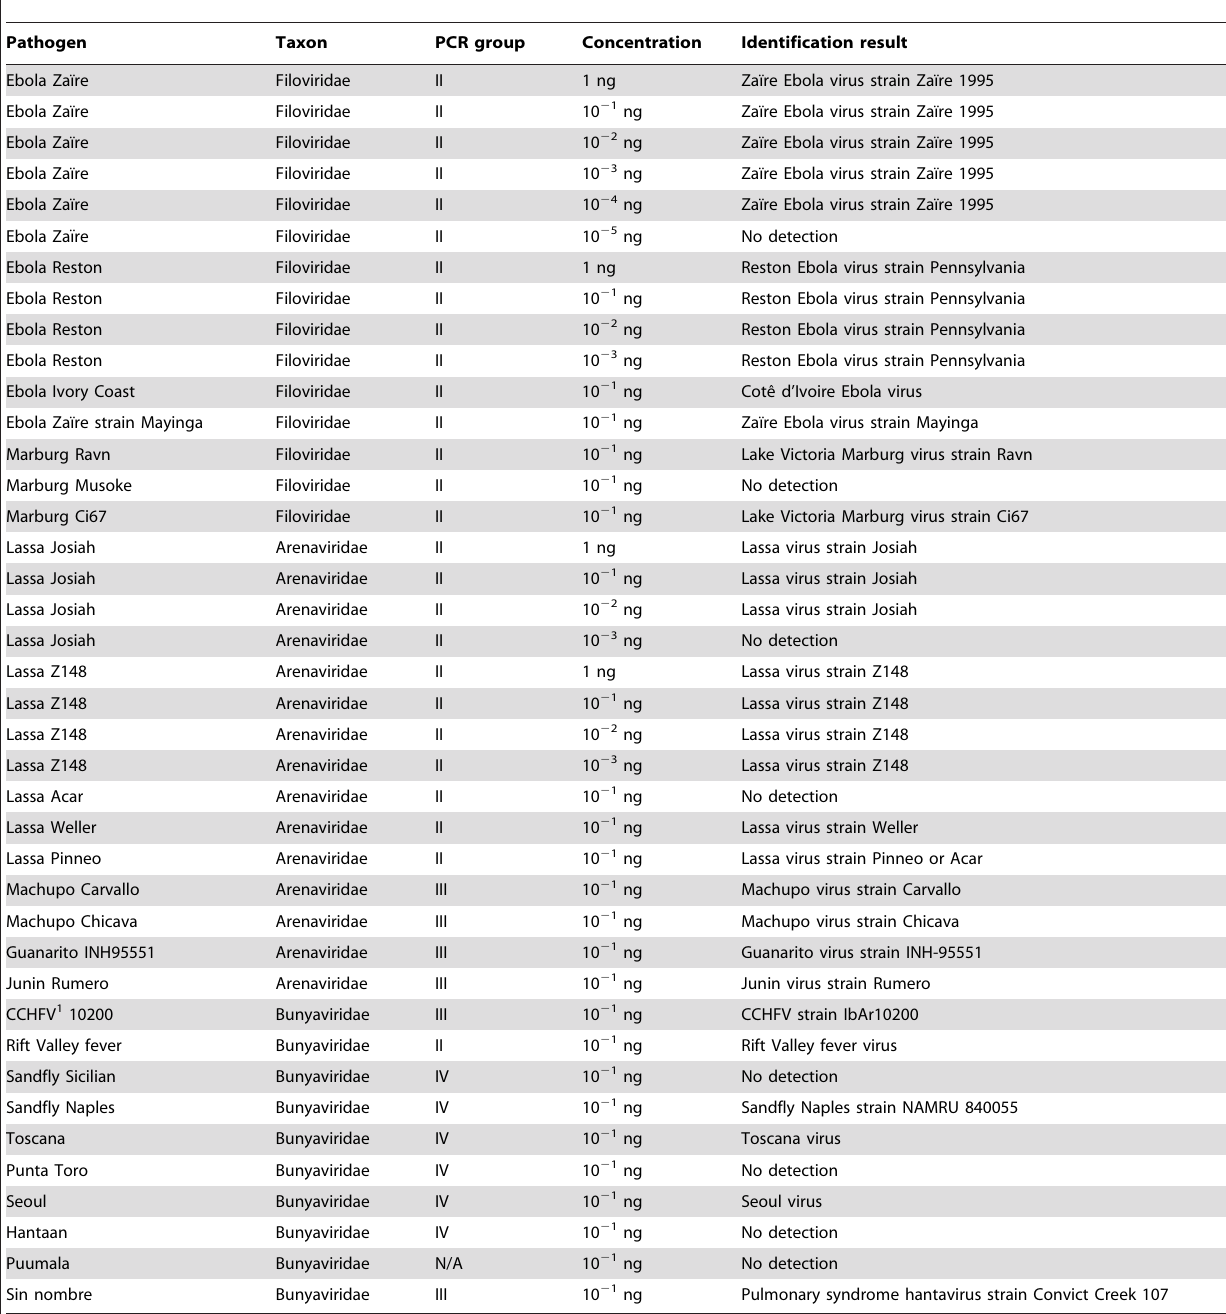
Table 2. Results of testing of the RPM-TEI using genomic preparations of selected viral agents.